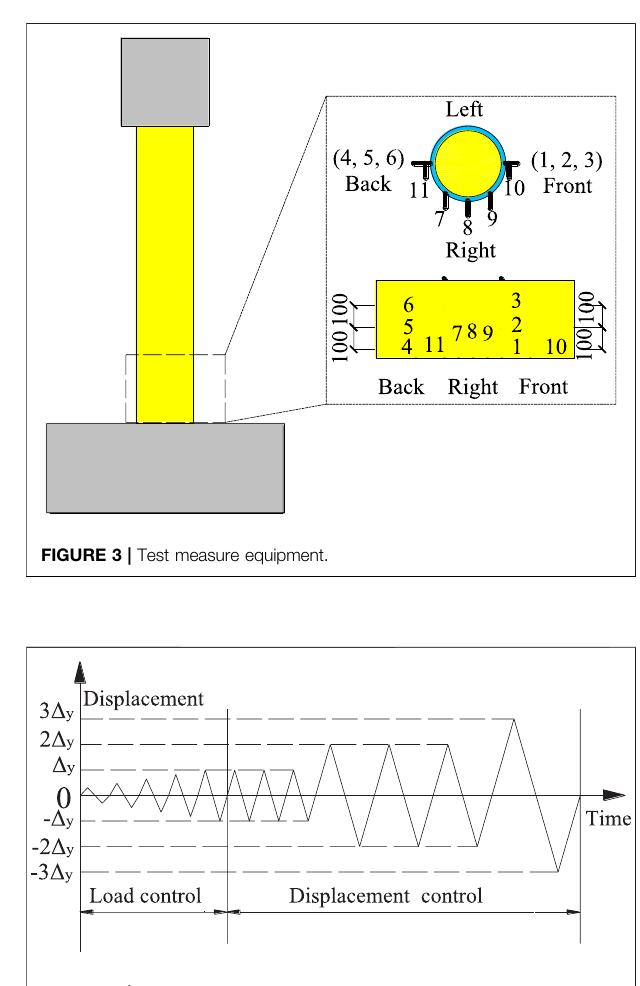
FIGURE 4 | Loading system of level load.